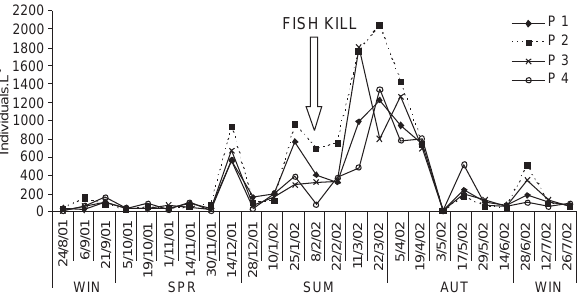
Figure 9. Temporal variation in total zooplankton density (individuals.m -3 ) detailed by sampling points. (WIN) Winter, (SPR) spring, (SUM) summer, (AUT)